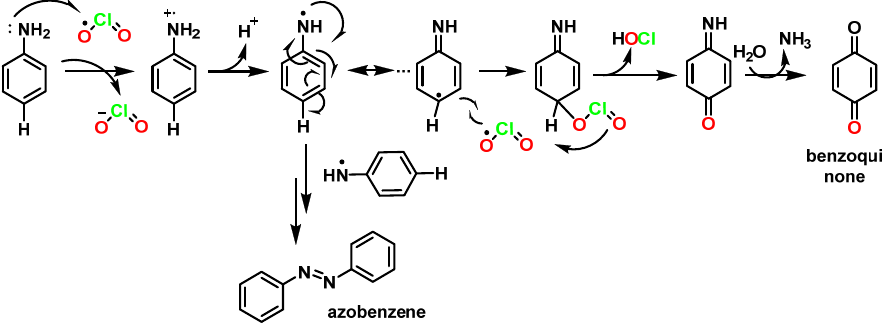
Figure 32. Mechanism for the oxidation of aromatic amines with ClO 2 .